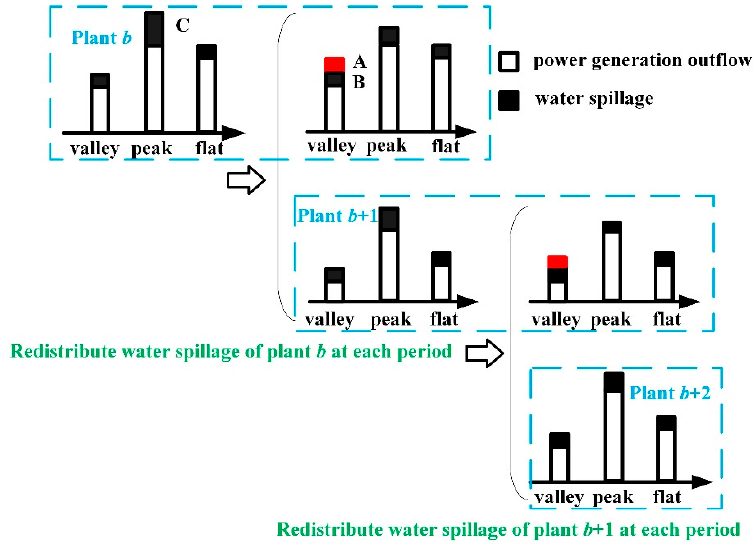
Figure 2. Adjustment process of the spillage adjustment strategy.